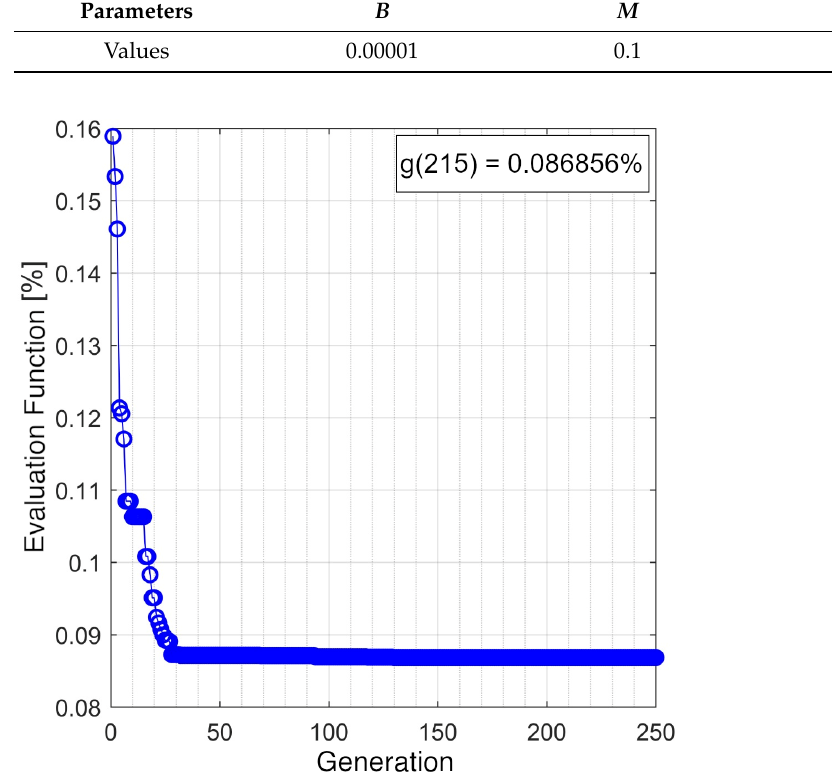
Figure 12. Presentation of the evaluation function values in the sliding controller optimization